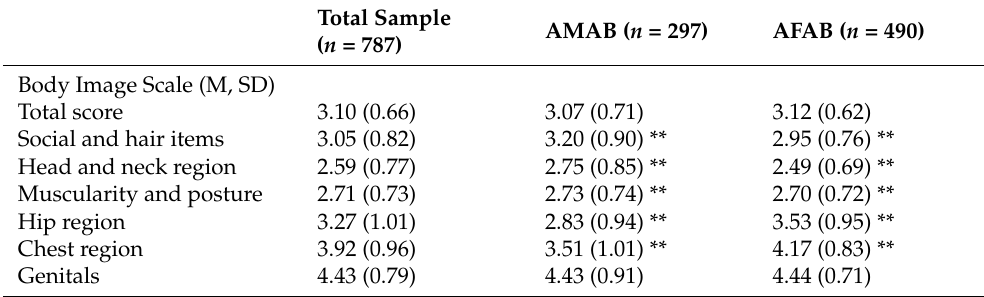
Table 2. Rating of body image satisfaction: total sample and separated for birth-assigned sex.